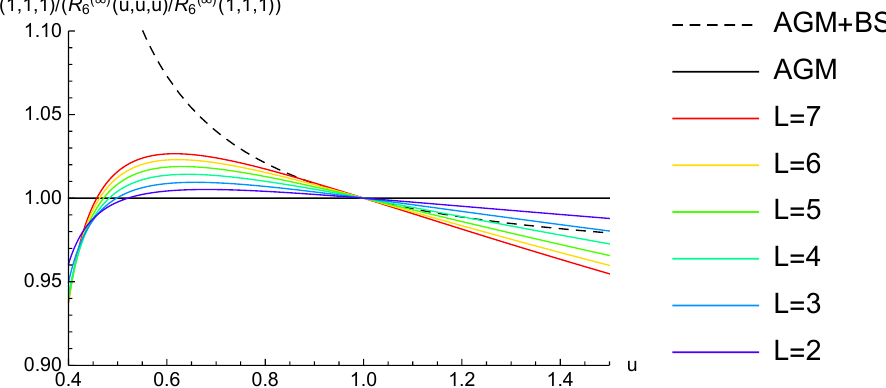
Figure 9 . For a limited range in u , we again plot R ( L ) by the strong-coupling result of AGM. We also show (dashed line) the strong-coupling result shifted by (cid:0) (cid:25)= 72, and normalized by the AGM